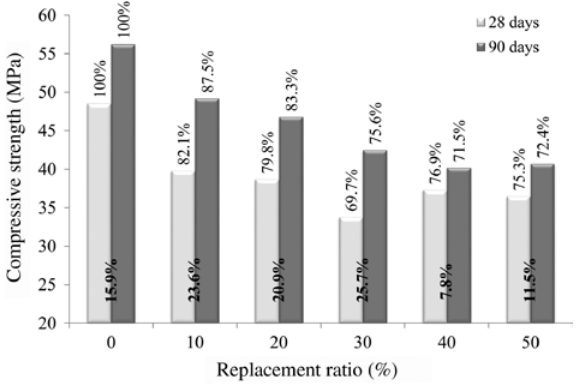
Figure 5: Compressive strength of series B. Figure 6: Compressive strength of series